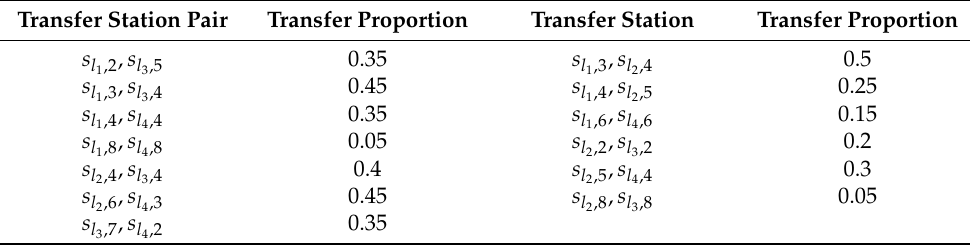
Table 1. Transfer station and transfer proportion.